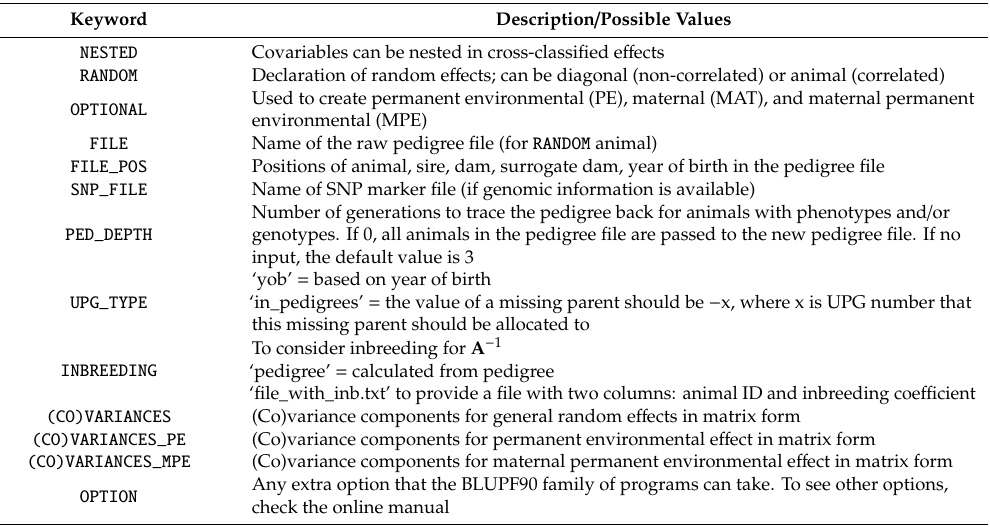
Table A3. Declaration of random e ff ects in renumf90 and all associated